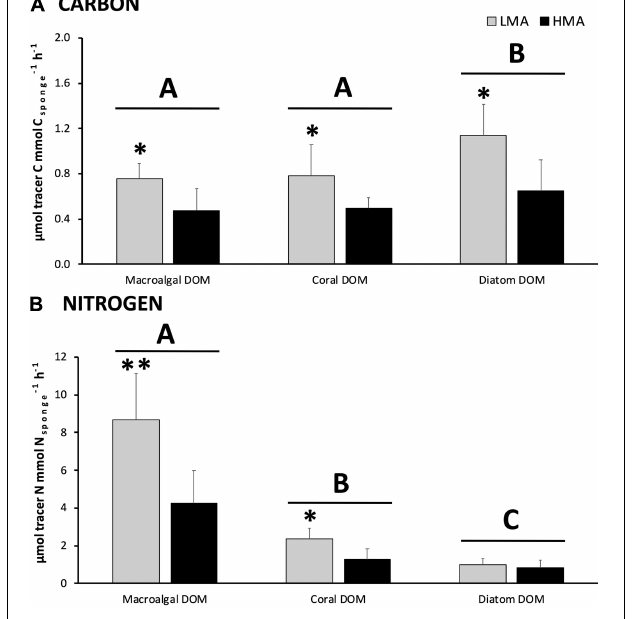
FIGURE 2 | DOM assimilation into bulk sponge tissue. Assimilation rates of (A) carbon and (B) nitrogen from each 13 C/ 15 N-enriched DOM source by sponge type (in gray LMA species and in black HMA species). Note the different scales for carbon and nitrogen. Data presented as mean assimilation